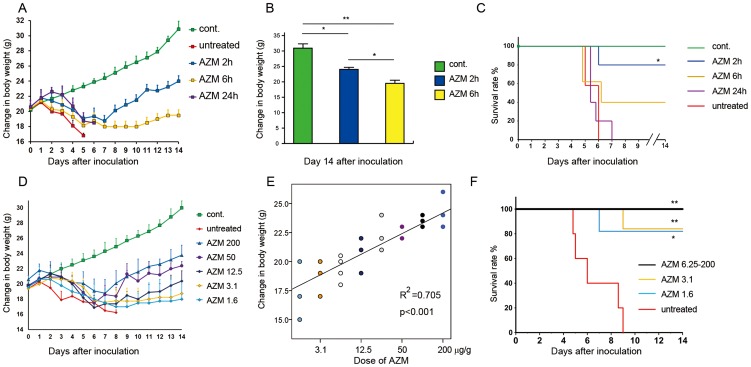
Effectiveness of a single dose of AZM in the E32511 model.(A) The administration of a single dose of AZM 2 h after infection significantly increased the BW of E32511-infected mice. (B) Mouse BW for AZM 2 h vs. AZM 6 h, p = 0.015 at day 14 after inoculation. Student's t test, *p<0.05; **p<0.001). (C) The administration of a single dose of AZM was significantly effective in the survival mice when given 2 h after infection, compared with 6 and 24 h after infection, (for AZM 2 h after infection vs. untreated, p = 0.012; AZM 2 h after infection vs. 24 h after infection, p = 0.013 and AZM 6 h and 24 h after infection vs. untreated, p>0.05. Log rank and χ2 test, (*p<0.05) (D) The administration of a single dose of 200–1.6 µg/g AZM 2 h after infection significantly increased the BW of E32511-infected mice. (E) The correlation between the dose of AZM and the increase in BW of E32511-infected mice was statistically significant, as shown by the Spearman's ρ (rho) = 0.887 and the p value, p<0.0001. Black-filled circle = AZM 100 µg/g; grey-filled circle = AZM 25 µg/g; empty circle = AZM 6.25 µg/g. (F) 1.6 µg/g AZM 2 h after infection with E32511 (1011 CFU/ mouse) was still effective in treating the E32511-infected mice, with a significant effect on the survival curve (200–6.25 µg/g AZM vs. untreated, p = 0.002; 3.1 µg/g AZM vs. untreated, p = 0.008 and 1.6 µg/g AZM vs. untreated, p = 0.016. Log rank and χ2 test, **p<0.01, *p<0.05.